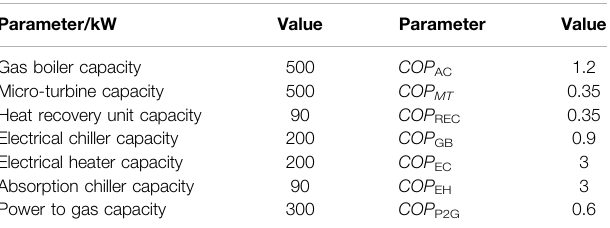
TABLE 3 | The operating parameters of the equipment in the